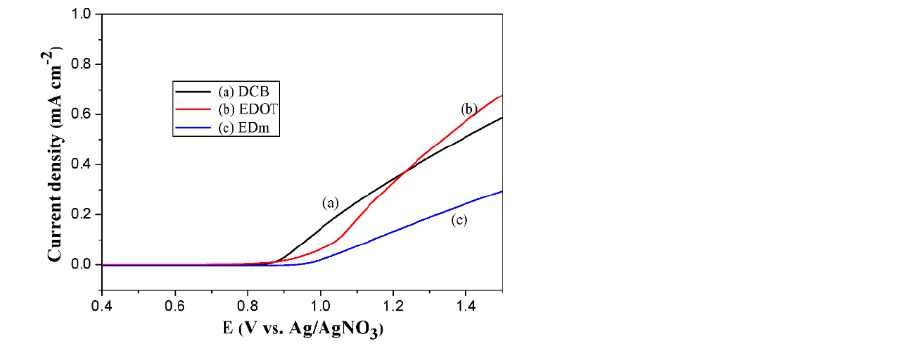
Figure 2. Electrosynthesized plots of ( a ) P(DCB), ( b ) P(DCB- co -ED), ( c ) P(2DCB- co -ED), ( d ) P(DCB- co -EDm), and ( e ) P(2DCB- co -EDm). The scan velocity is 100 mV s − 1 . The oxidized peaks of P(DCB), P(DCB- co -ED), P(2DCB- co -ED), P(DCB- co -EDm), and P(2DCB- co -EDm) were located at 0.77, 0.72, 0.74, 0.73, and 0.72 V, while the reduced peaks of P(DCB), P(DCB- co -ED), P(2DCB- co -ED), P(DCB- co -EDm), and P(2DCB- co -EDm) were